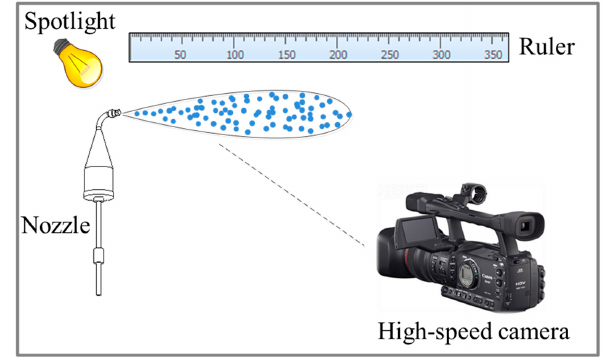
Figure 7. The droplet size distribution of di ff erent urea injection rates.